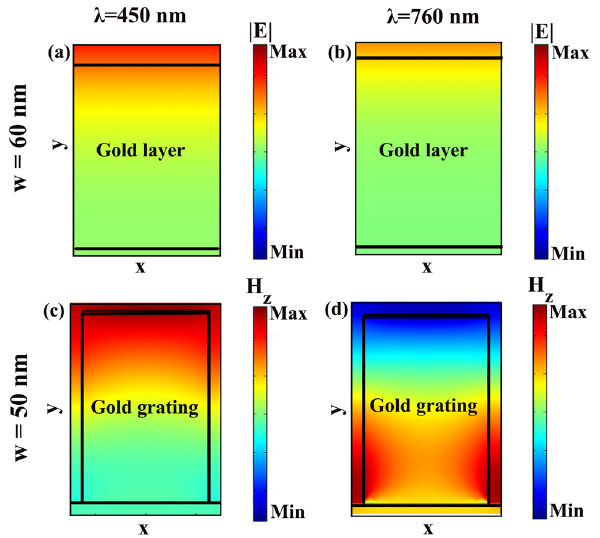
Figure 3. Electric field distribution of the structure when 110 nm-thick uniform gold layer covers the MoS 2 monolayer at ( a ) (cid:31) = 450 nm and ( b ) (cid:31) = 760 nm. Distribution of the z − component of the magnetic field, H z , of the structure when gold grating with h = 110 nm, p = 60 nm, and w = 50 nm covers the MoS 2 monolayer at ( c ) (cid:31) = 450 nm and ( d ) (cid:31) = 760